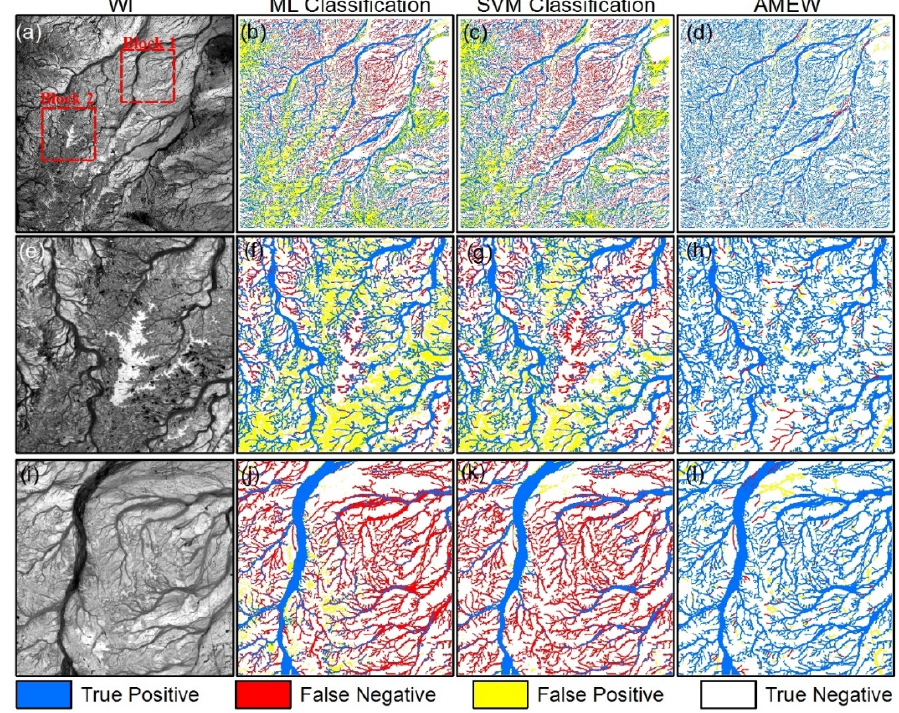
Figure 9. ( a ) NWI image of Study Area 1; ( b – d ) extraction results for Study Area 1; ( e ) NWI image of Block 1; ( f – h ) extraction results for Block 1; ( i ) NWI image for Block 2; ( j – l ) extraction results for Block 2. For further illustrations of results, see Figures S3 and S4 in the supplementary online materials. Table 3. Performance evaluation of the ML classifier, the SVM classifier and the AMEW.